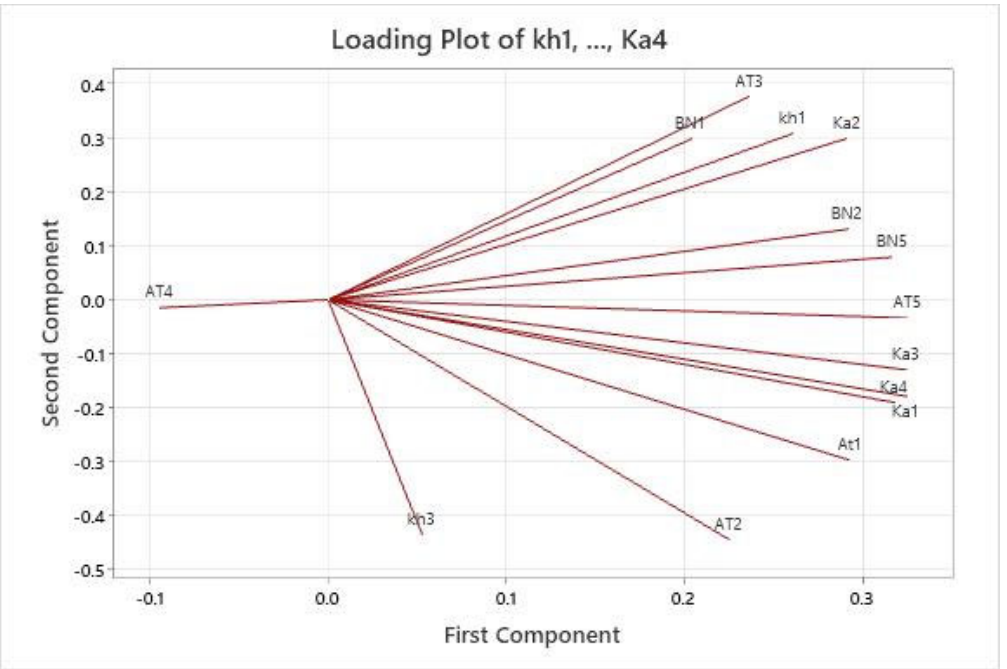
Figure 2. Biplot of the first two principle components (PCs) for the studied accessions of myrtle under greenhouse conditions.